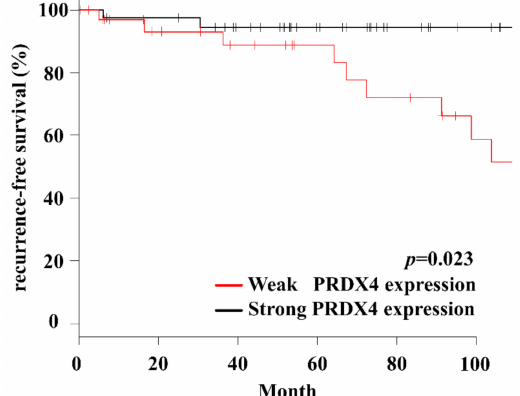
Figure 3. Kaplan–Meier curve for recurrence-free survival (RFS) in patients after PTC surgery according to theexpressionofPRDX4.